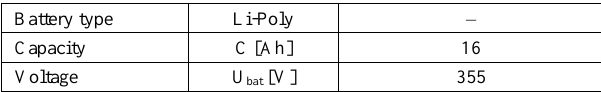
Table 6. Specifications of the hybrid battery